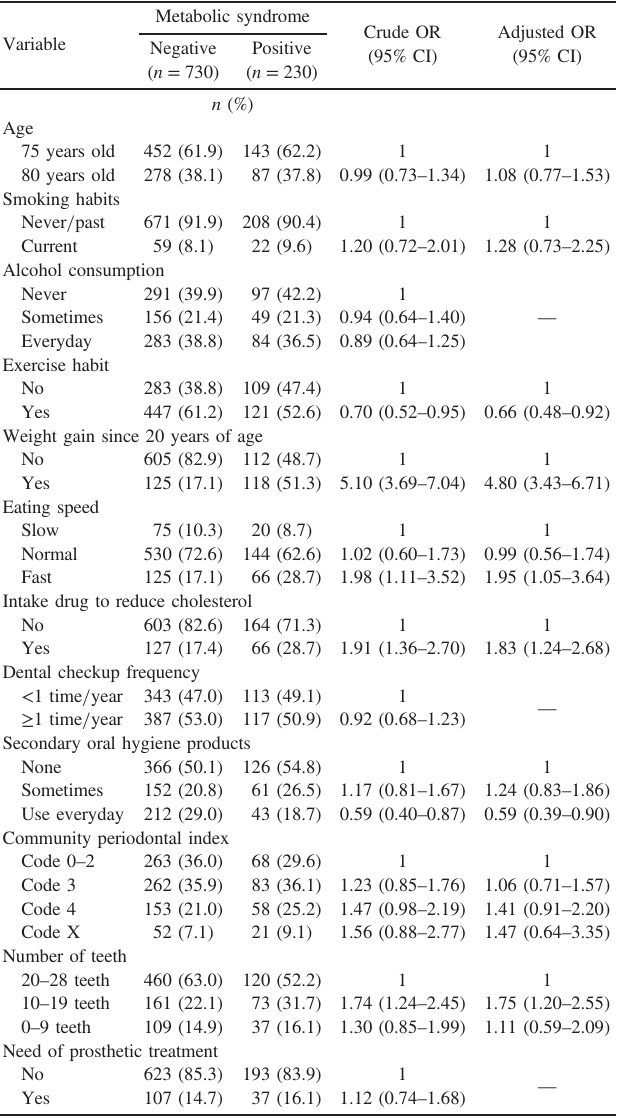
Table 3. Relation of oral health, life-style factors, and other variables to Metabolic syndrome in men